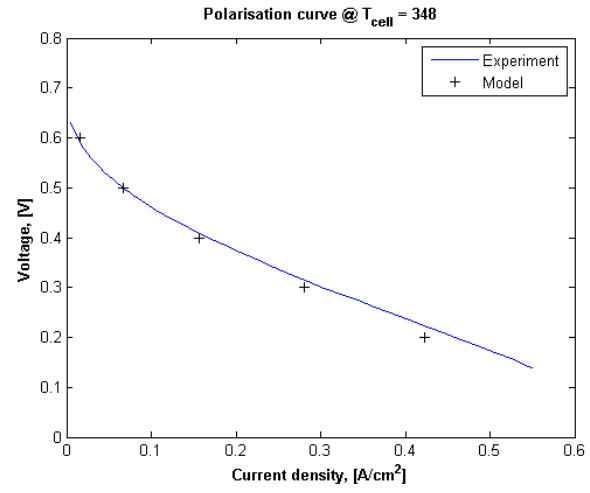
Figure 4. Comparison of calculated performance curve and experiments.